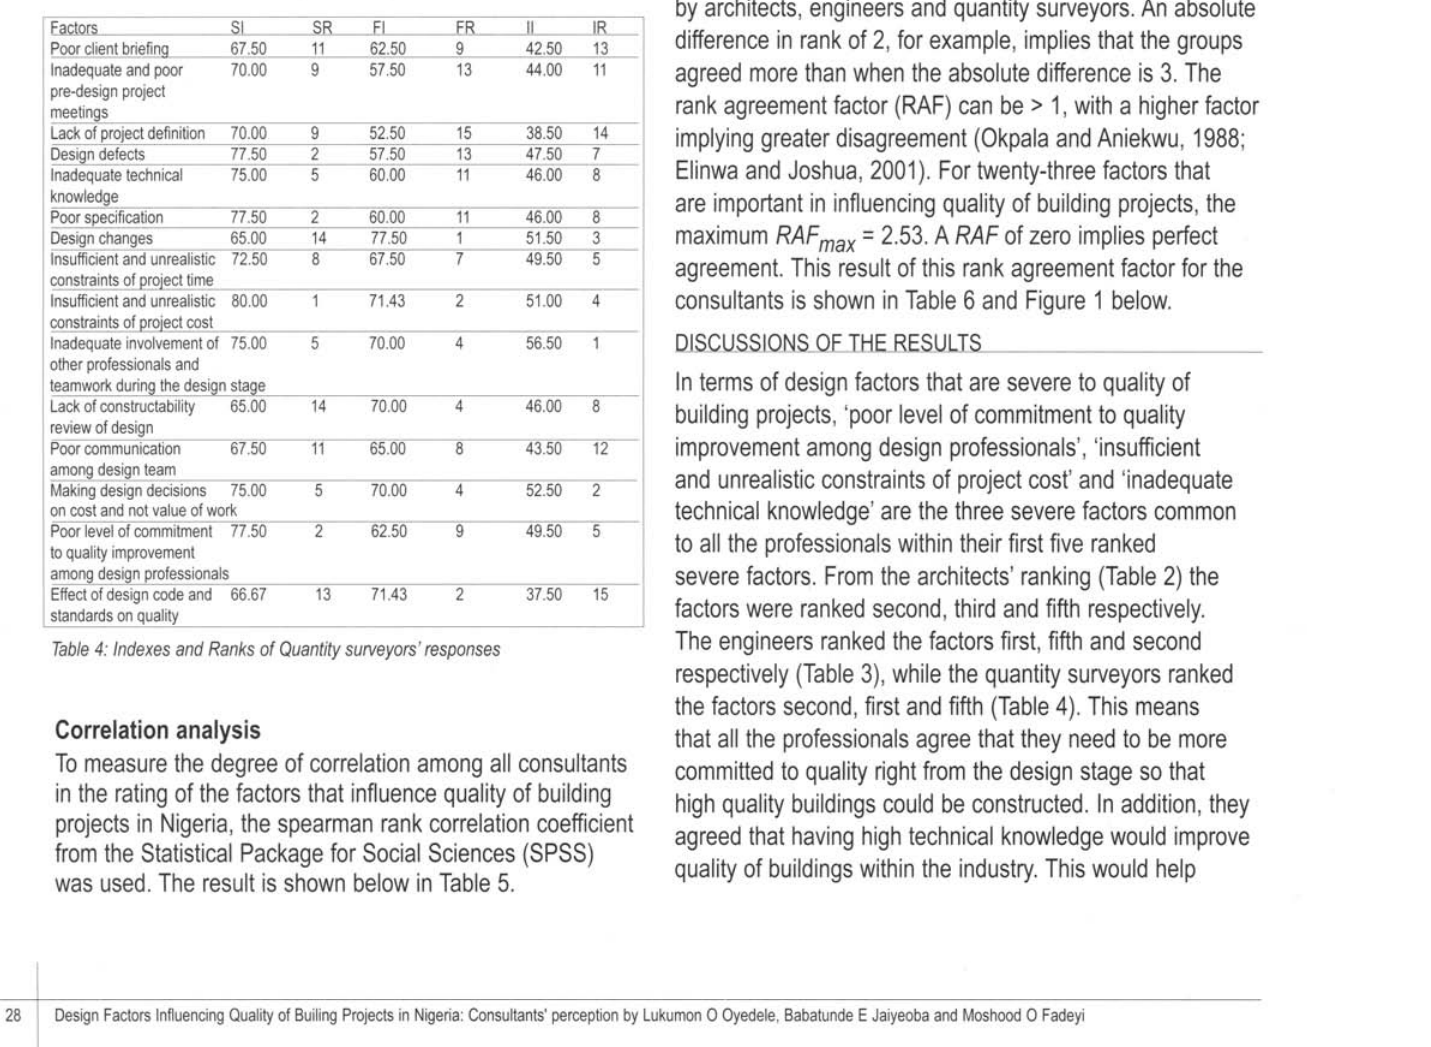
Table 3: Indexes and Ranks of Engineers' responses FaQtQrs Poor client briefing